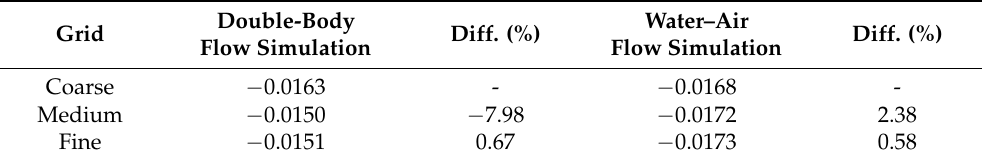
Table 5. Grid independence analysis for straight-ahead